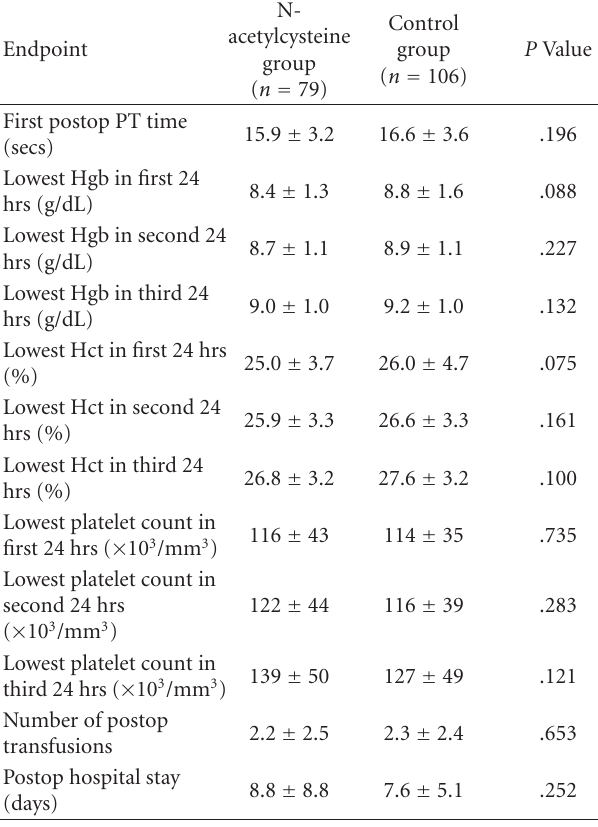
Table 4: Secondary Endpoints.